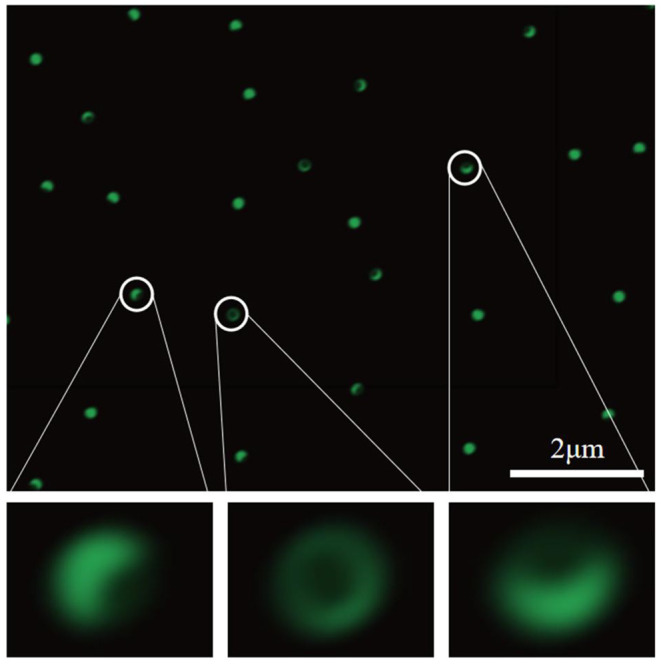
Fluorescence microscope image of Janus particles with green fluorescence dispersed in the solution.